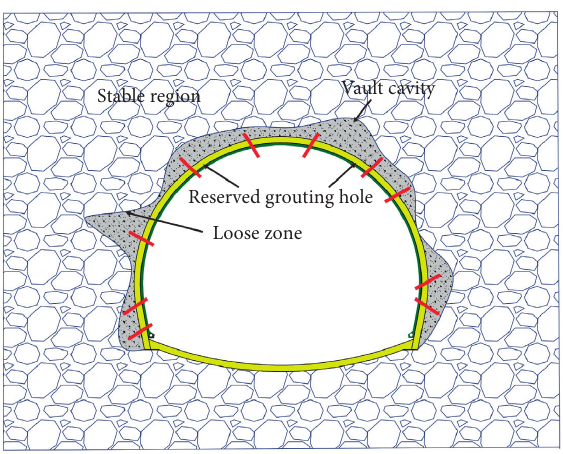
Figure 12: Grouting distribution behind initial